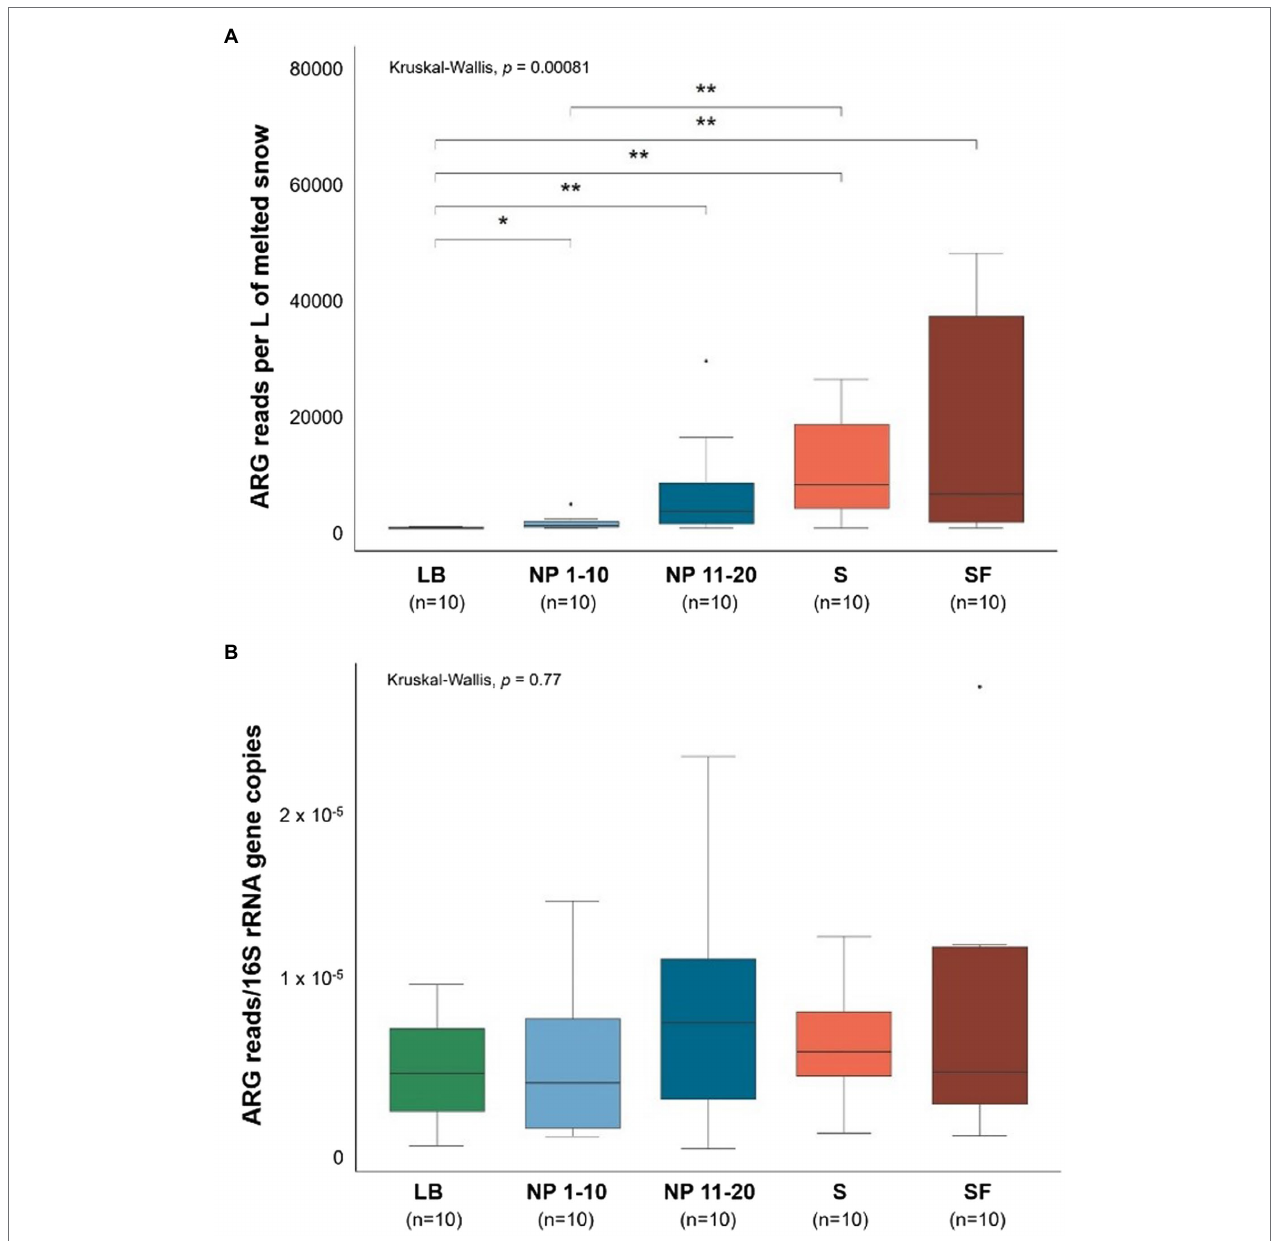
FIGURE 3 | Size of the snow antibiotic resistome. LB: ridge from the catchment with human transit. NP 1–10: open spaces from the unaffected catchment. NP 11–20: forested area from the unaffected catchment. S: paths from the catchment with human transit. SF: forest areas from the catchment with human transit. Total ARG copies per site normalized by (A) L of melted snow and (B) by copies of the 16S rRNA gene. Data normality was checked using the Shapiro–Wilk test ( A : p = 1 × 10 − 9 and B : p = 7.83 × 10 − 5 ). Significant differences between sites were determined by pairwise Wilcoxon signed-rank tests. * p ≤ 0.05 and ** p ≤ 0.01. n =